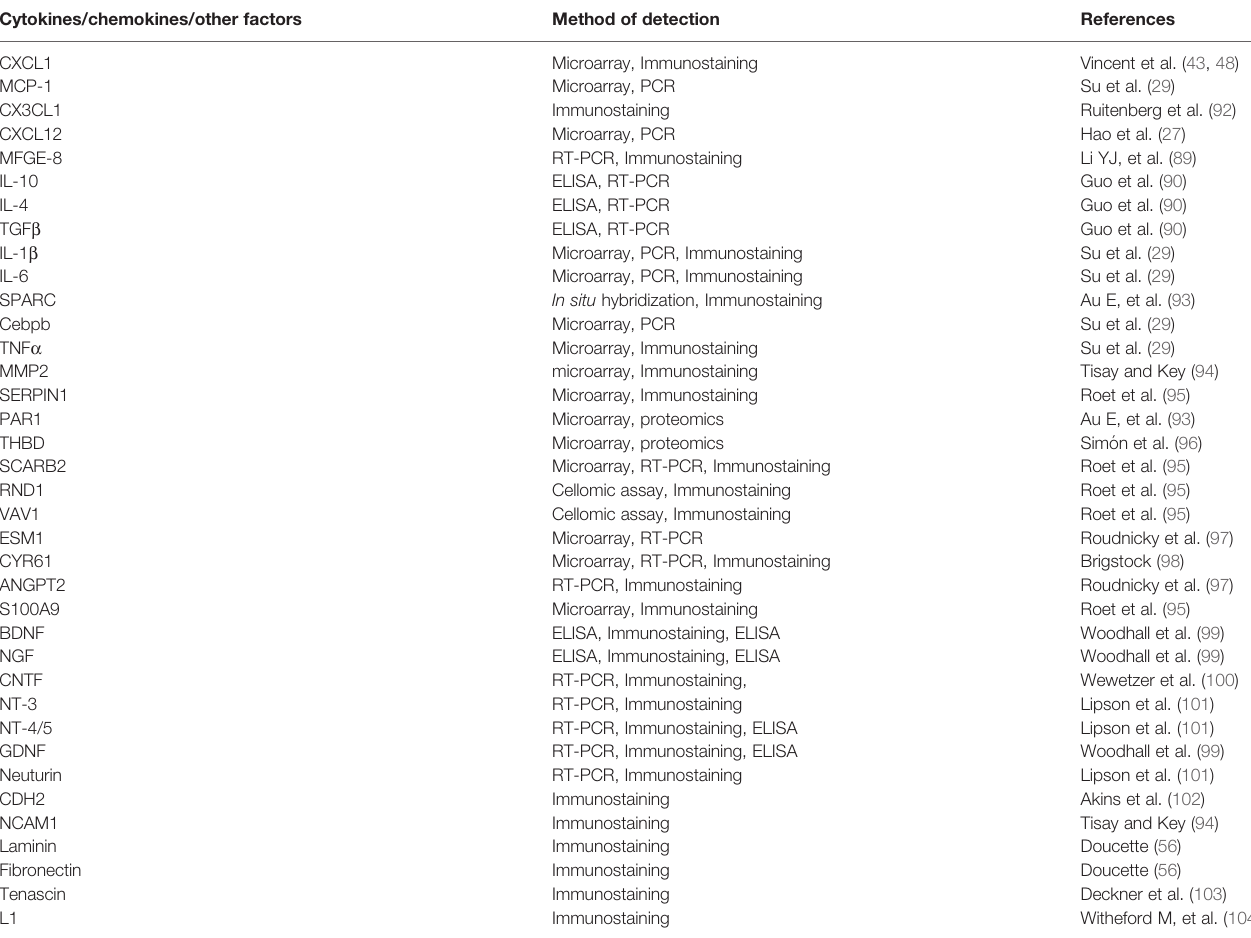
TABLE 1 | Main cytokines, chemokines and other factors expressed in olfactory ensheathing cells. Cytokines/chemokines/other